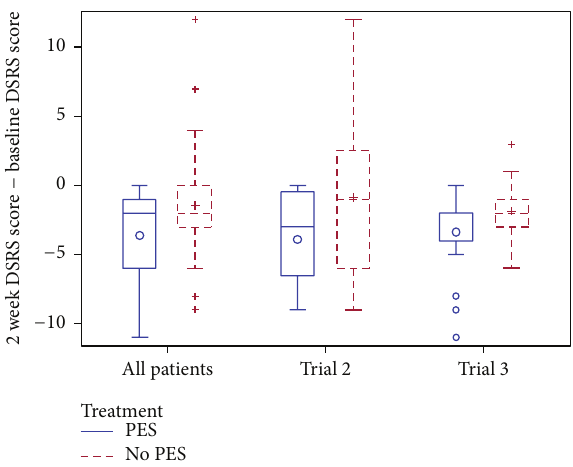
Figure 3: Box and whisker plot of change in dysphagia severity rating scale (DSRS) from baseline to two weeks, by source trial. Comparison of pharyngeal electrical stimulation (PES) versus no PES by multiple linear regression with adjustment, overall mean difference − 1.7 (95% confidence interval − 3.2, − 0.1; 𝑝 = 0.040 ); no difference between trials ( 𝑝 = 0.18